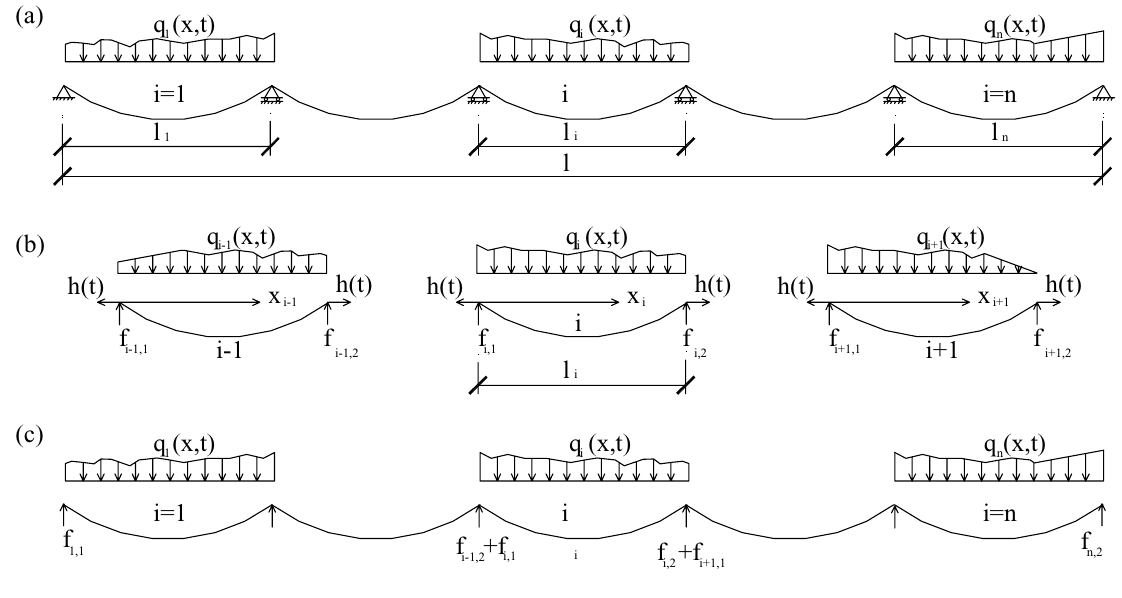
Fig. 2. Definition diagram for a multi-span cable